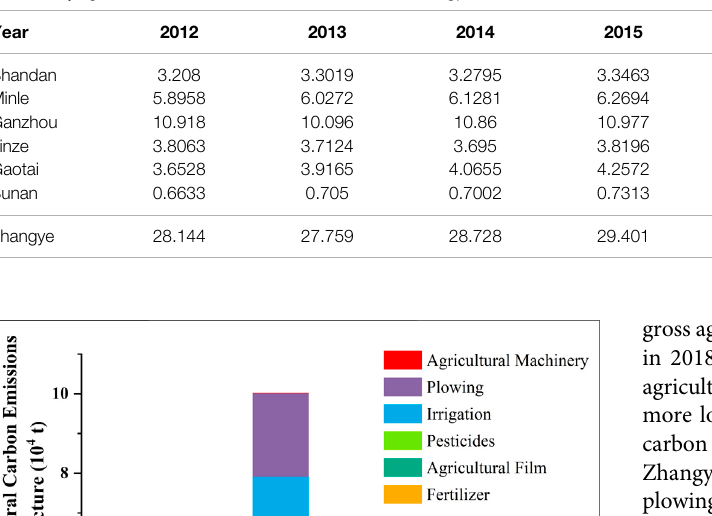
TABLE 5 | Agricultural carbon emissions of counties in Zhangye from 2012 to 2019.